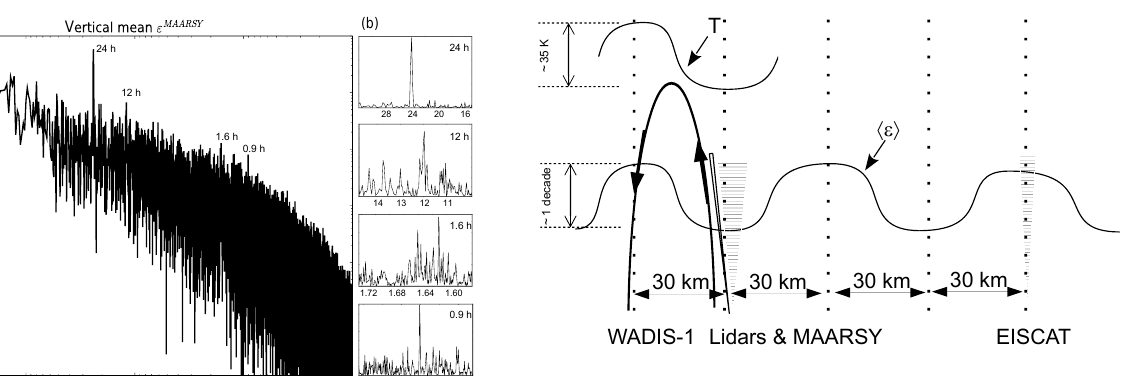
Figure 19. Schematics of the observed spatial variability: (cid:104) ε (cid:105) mod- ulation, temperature variation, and its relation to the locations of measurements. See text for